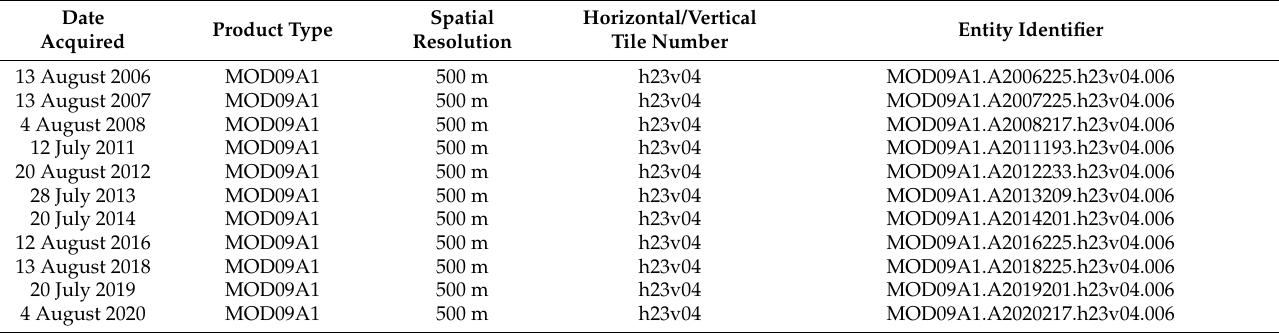
Table A2. Information about the MODIS remote sensing data used in this